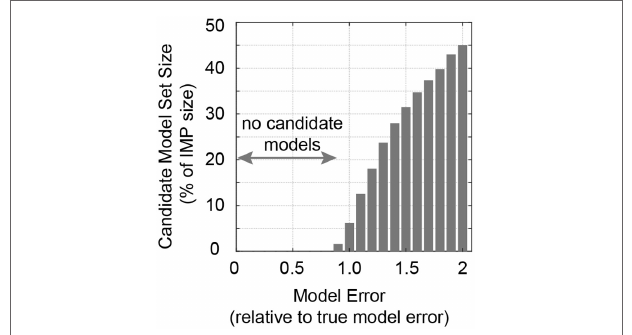
FIGURE 12 | Size of the candidate model set evaluated for changing levels of model error estimations.